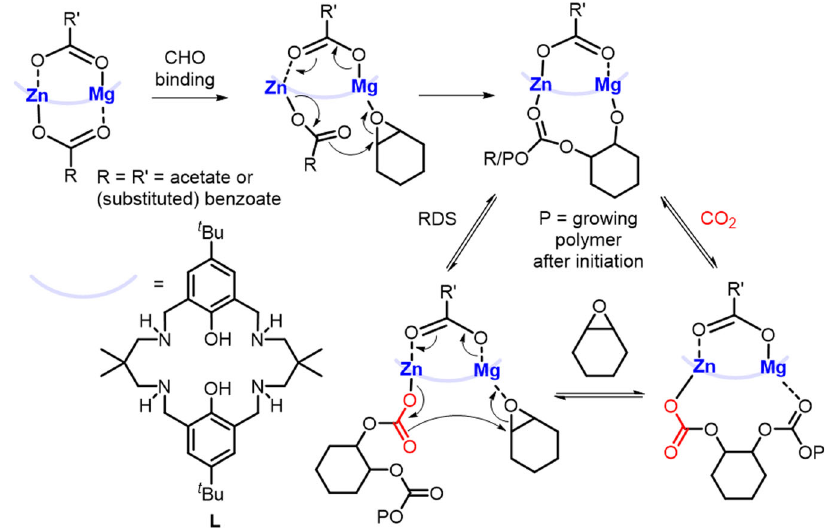
Fig. 6 Heterometallic chain-shuttling mechanism. Proposed mechanism for CHO/CO 2 ROCOP with heterometallic complexes 22a-h 88